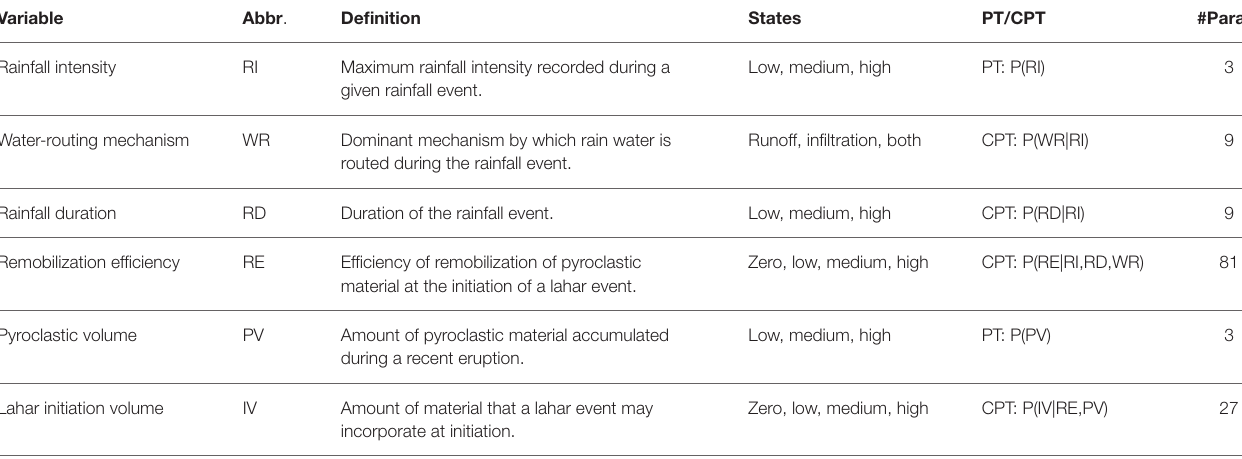
TABLE 1 | Physical variables included in the Bayesian Belief Network (BBN) model Multihaz . Variable